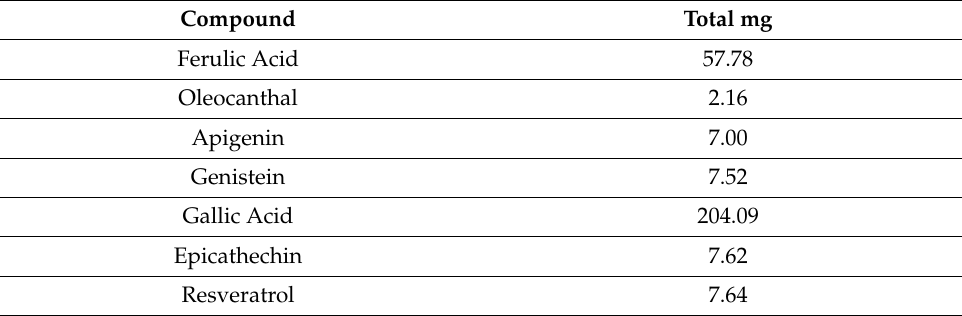
Table 4. Anti-inflammatory compounds present in the outlined meal plan in Table